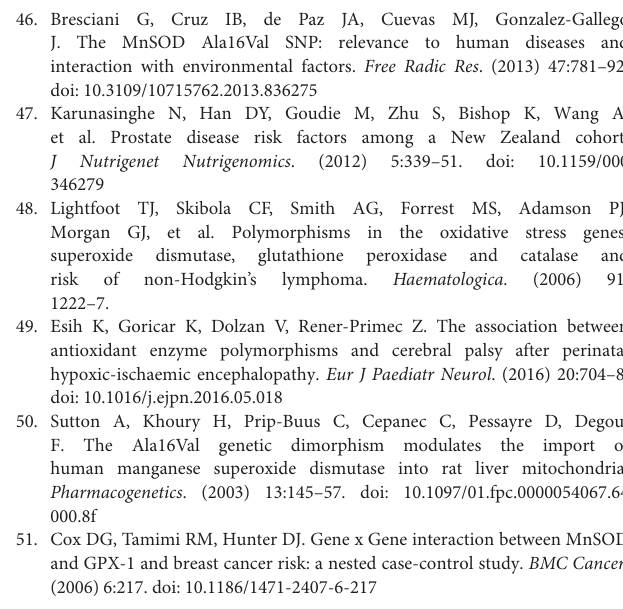
and GPX-1 and breast cancer risk: a nested case-control study. BMC Cancer . (2006) 6:217. doi: